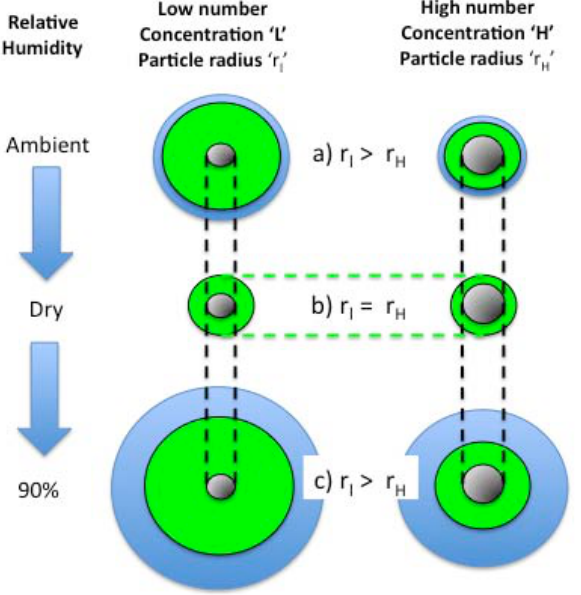
Fig. 3. Schematic showing the change in condensed organic mate- rial (green areas) on particles with an existing organic core (black areas) as a function of RH (left panel) and the effect on water up- take (blue areas) for a specific aerosol size and two separate number concentrations (the middle panel represents a low number concen- tration, the right a high concentration). The dry size for both popu- lations, as measured by the instrument, are equal (the middle row).